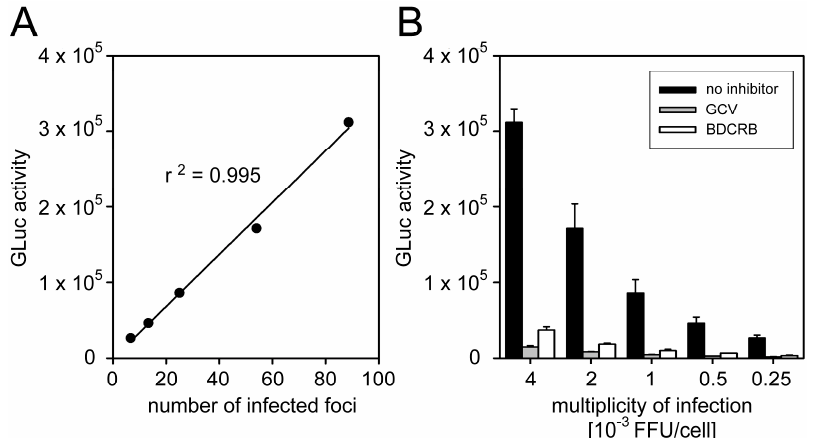
Figure 1. Inhibition of focal growth reflected by Gaussia luciferase (GLuc) activity. Human foreskin fibroblasts (HFFs) were seeded and infected with Merlin-pAL1502-GLuc in a dilution series in the range of 0.00025–0.004 focus-forming units/cell (FFU/cell) resulting in six to 80 infected foci per